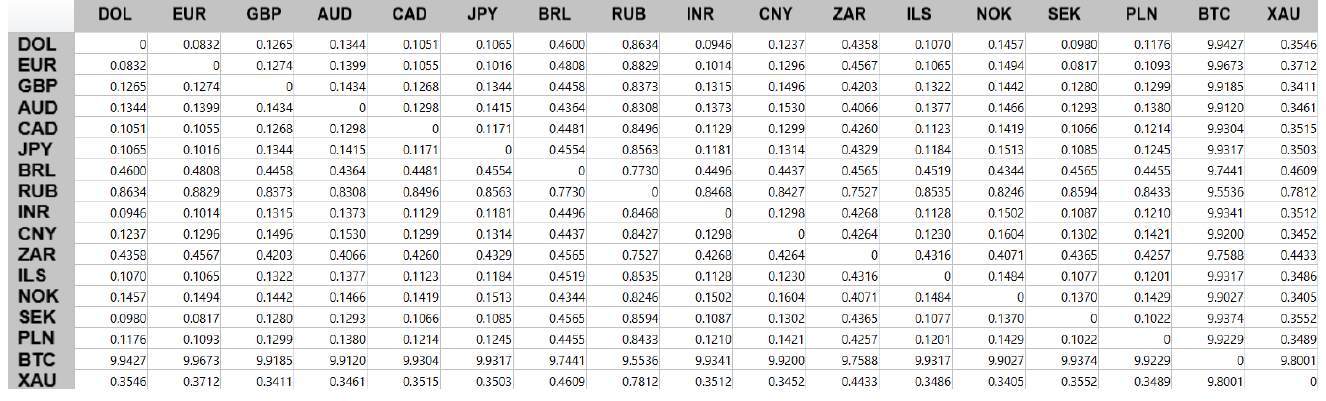
Figure 9. New matrix of